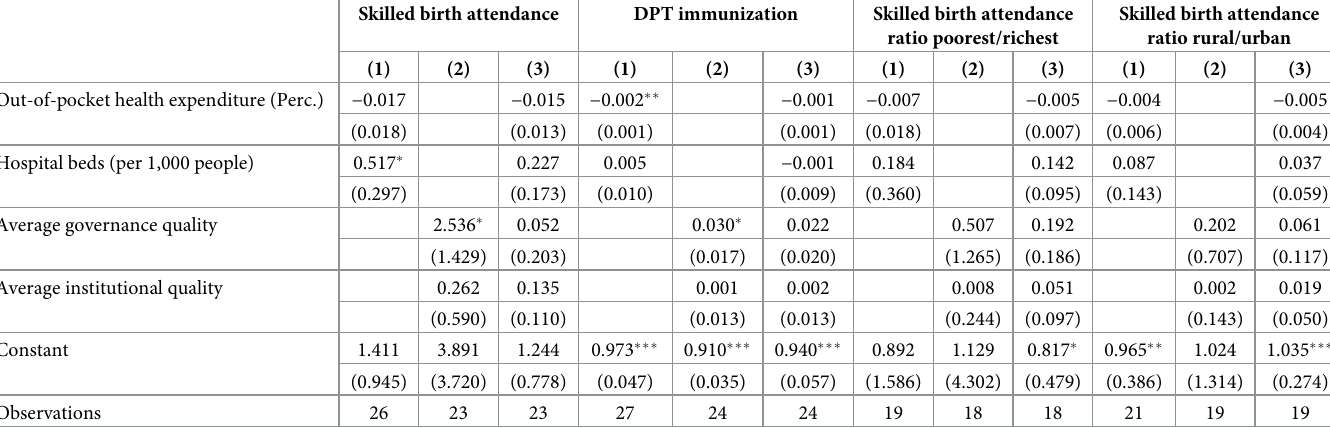
Table 3. Regression results of potential efficiency determinants: Service access and equity of